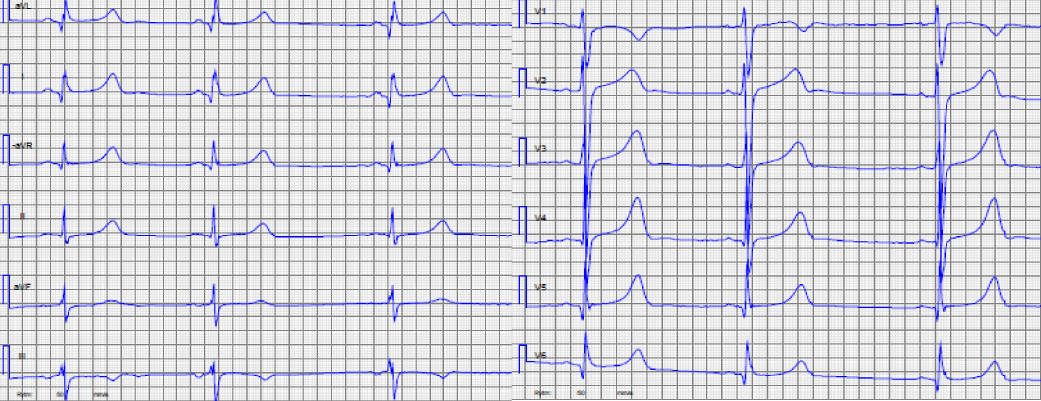
Figure 5. Index patient, Family 3, ECG at the age of 14 years with prolonged QTc. At this time, the echocardiogram revealed only mild left ventricular hypertrophy.